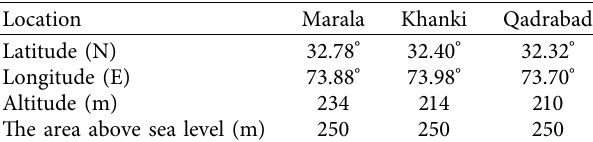
Figure 1: (a) Represents the scaling function of symlet wavelet with vanishing moment 15; (b) denotes the wavelet function of symlet wavelet with vanishing moment Table 1: Summary of gauging stations of the Chenab river basin.